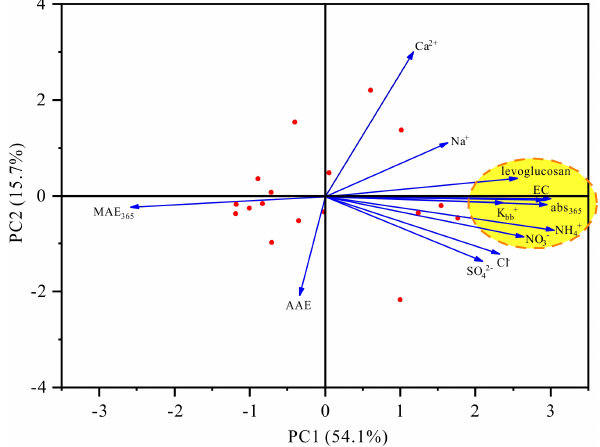
Figure 5. Principal component analysis results for the optical prop- erties of HULIS and chemical compositions of PM 2 . 5